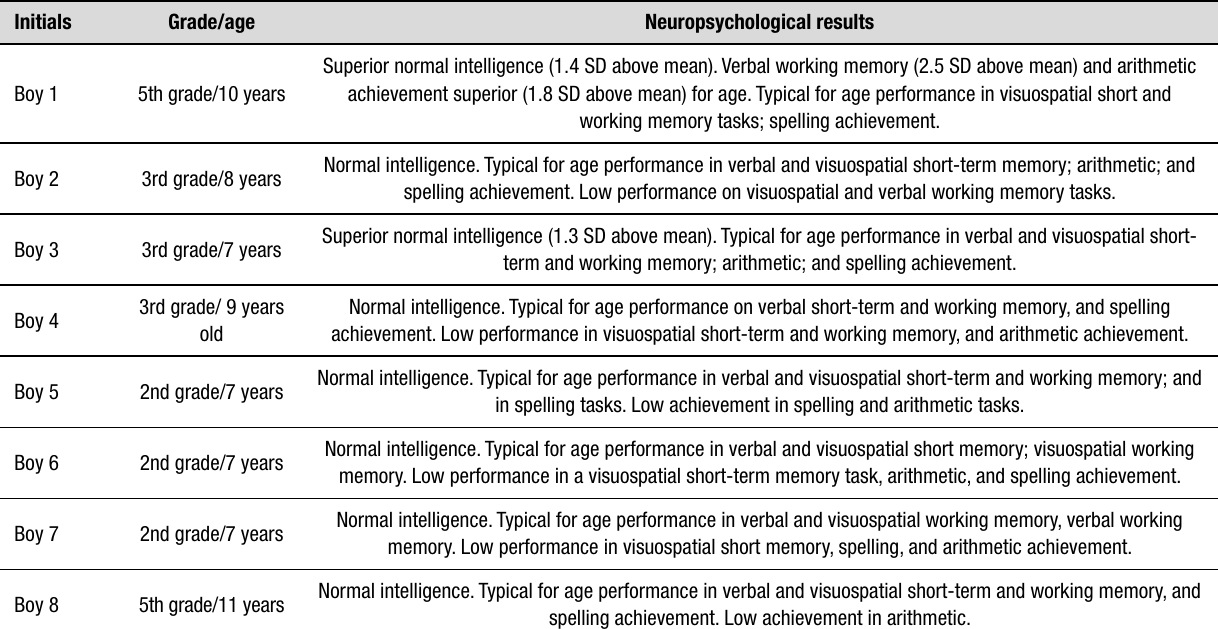
Table 3. Qualitative neuropsychological results for the boys having the MAOA_LPR*2R allele. Initials Grade/age Neuropsychological